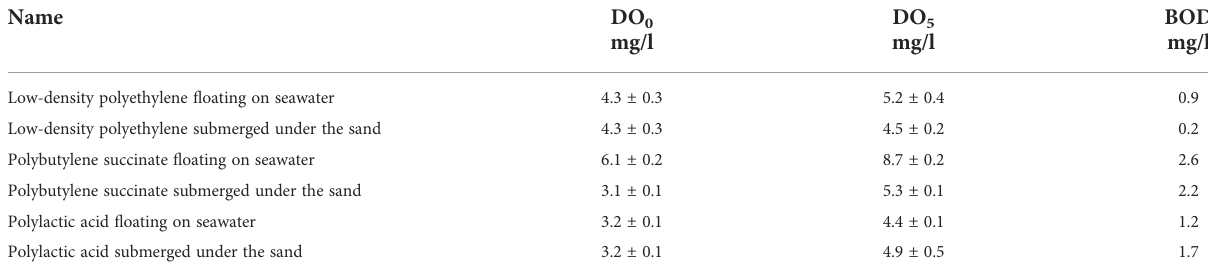
TABLE 3 Biochemical oxygen demand of the seawater after the biodegradability of